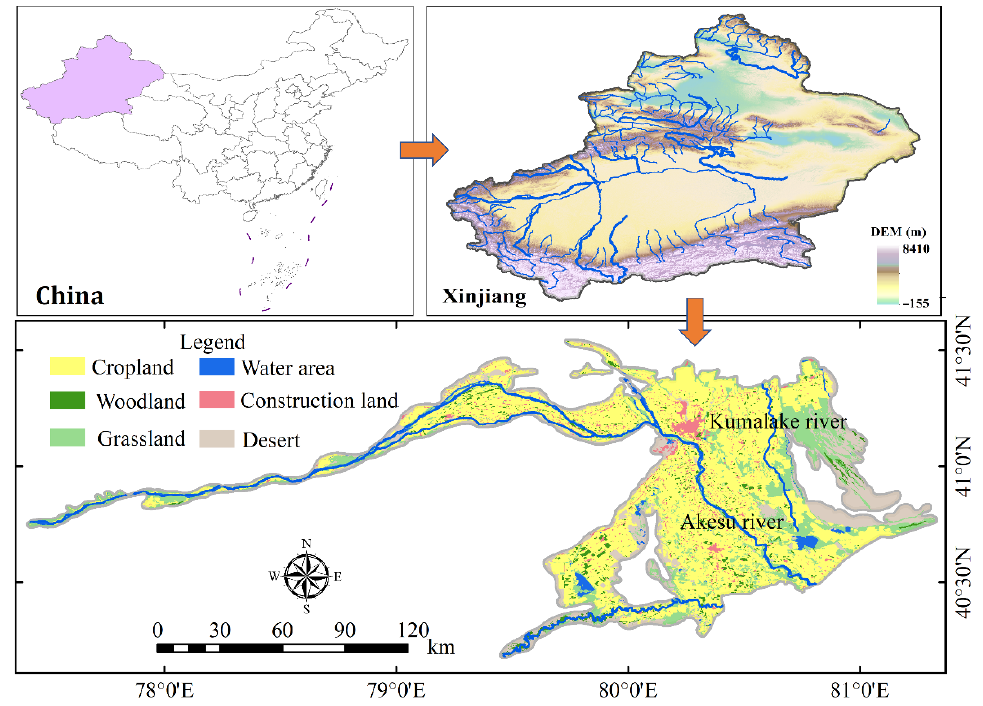
Figure 1. Overview of study area.